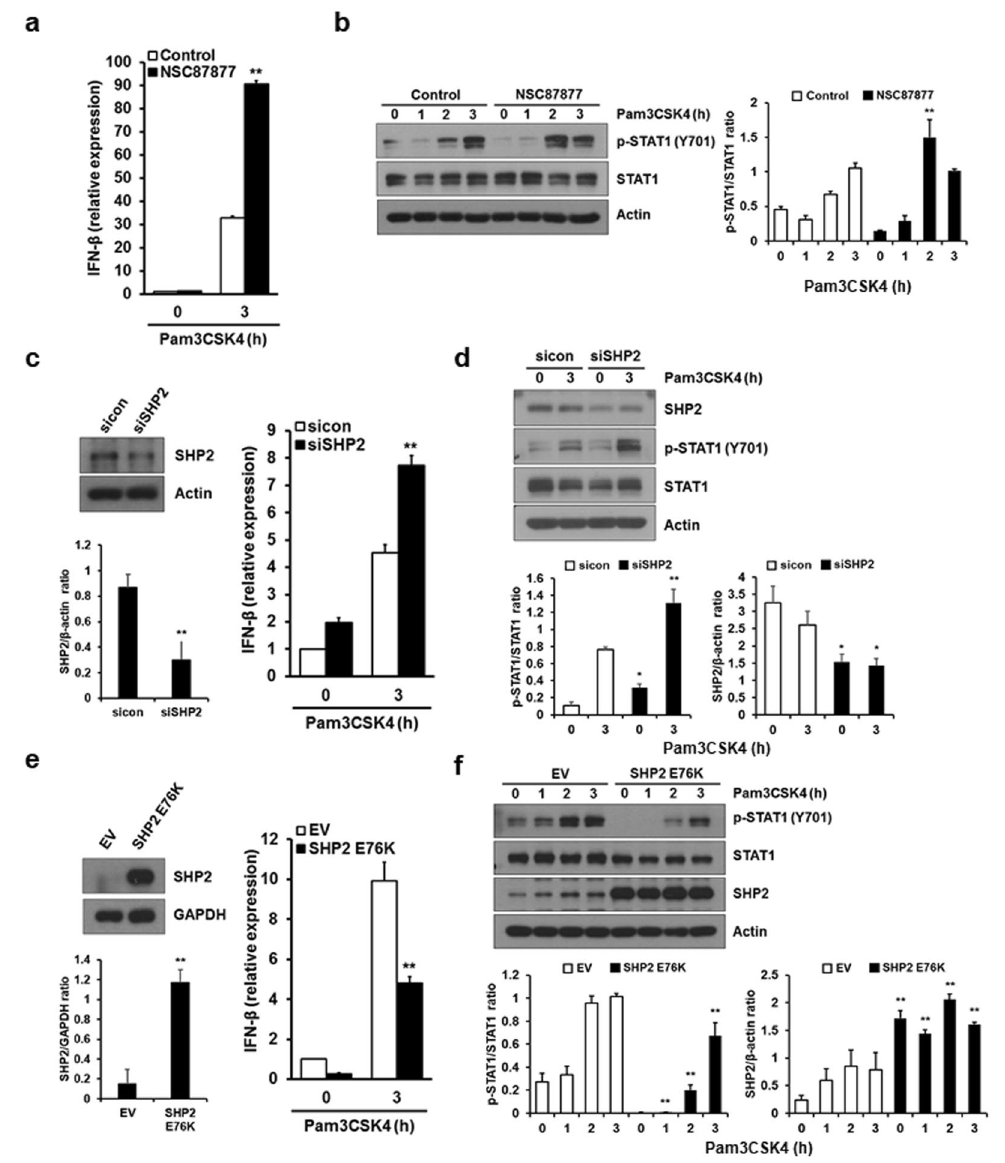
Figure 1. SHP2 negatively regulates IFN- β induction by TLR2 ligands. ( a , b ) BMDMs were pretreated with 50 μ M SHP2 inhibitor, NSC87877, for 1 h and stimulated with 1 μ g/ml Pam3CSK4 for the indicated times. IFN- β mRNA expression was determined by real-time PCR and the values were normalized to β -actin mRNA expression ( a ). STAT1 phosphorylation and expression levels were determined by Western blotting ( b ). ( c , d ) BMDMs were transfected with 50 nM control siRNAs (sicon) or SHP2-specific siRNAs (siSHP2) and stimulated with 1 μ g/ml Pam3CSK4 for the indicated times. IFN- β mRNA levels were measured as demonstrated in ( c ). Western blotting was performed to determine the phosphorylation and expression levels of STAT1 and SHP2 protein levels ( d ). ( e , f ) BMDMs were infected with a retrovirus expressing pMX-Puro (EV) or constitutively active SHP2 (SHP2 E76K). After puromycin selection, 1 μ g/ml Pam3CSK4 was applied for the indicated times. Experiments were performed as described in ( c , d ). Representative Western blots and quantification (shown in the bar graph) of indicated proteins/control ratio in the lysates of cells are shown in ( b , c , d , e , f ). Data represent the average of triplicate samples ± SD and are representative of at least three experiments. Statistical analyses were done using Student’s t -test ( * P < 0.05, ** P < 0.01). The uncropped images are in Supplementary Fig.